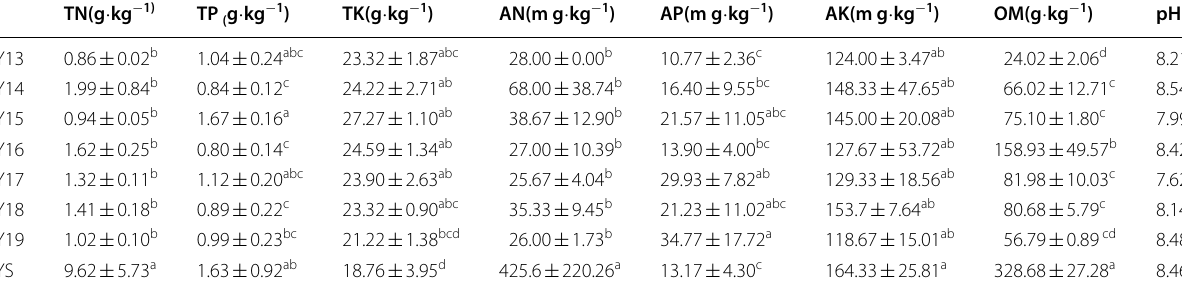
Table 1 Physical and chemical materials of